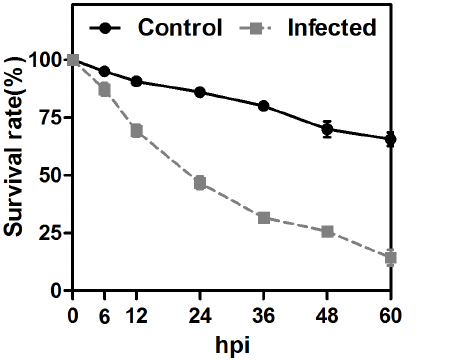
Figure 1. The survival curve of whitefly adults after infection of P.aeruginosa via oral ingestion. Error bars: 6 SE of the mean.